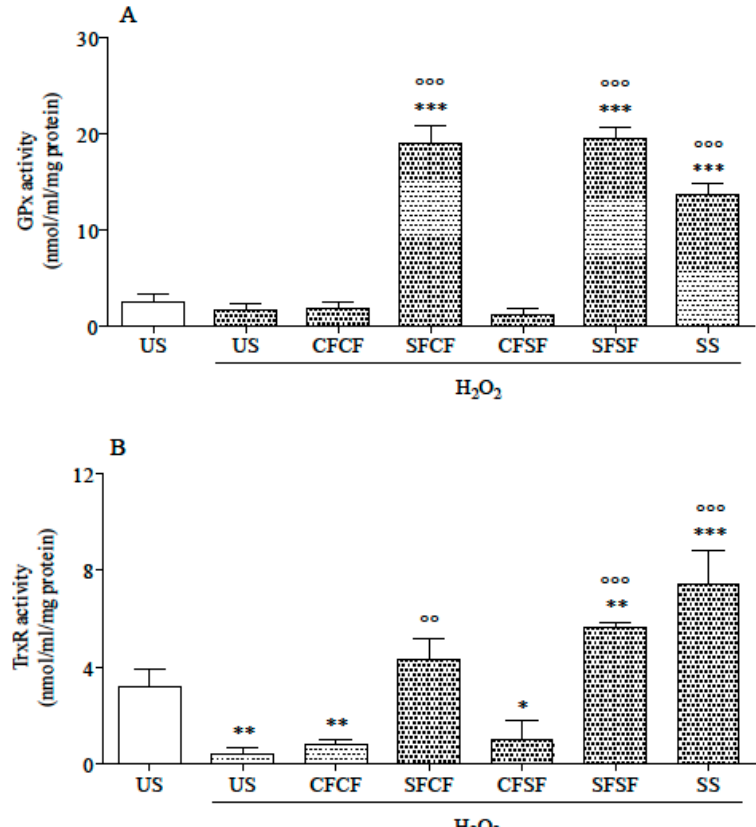
Figure 4. Glutathione peroxidase ( A ) and thioredoxine reductase ( B ) activity. GPx (panel A) and TrxR (panel B) activity is expressed as nmol/mL/mg protein. All data are means ± SD of at least six samples derived from three independent experiments. Statistical analysis was by one-way ANOVA (A: p < 0.001; B: p < 0.001) using Dunnet’s post-hoc test to compare stressed cells to US, not stressed ones (* p < 0.05; ** p < 0.01; *** p < 0.001), and supplemented stressed cells to US stressed ones ( ◦◦ p < 0.01; ◦◦◦ p < 0.001).